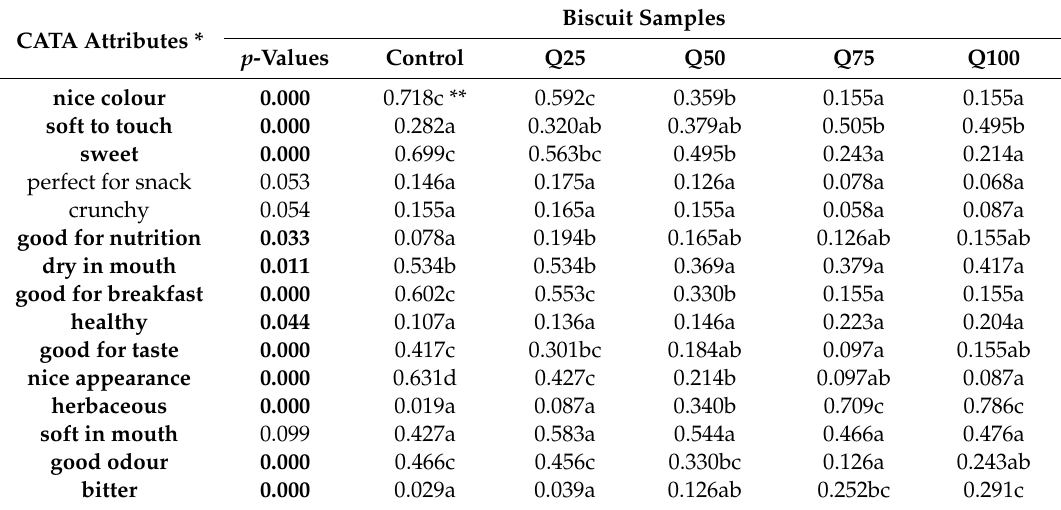
Table 4. Influence of di ff erent substitution rates of QF on Cochran’s Q test results for GF ladyfinger